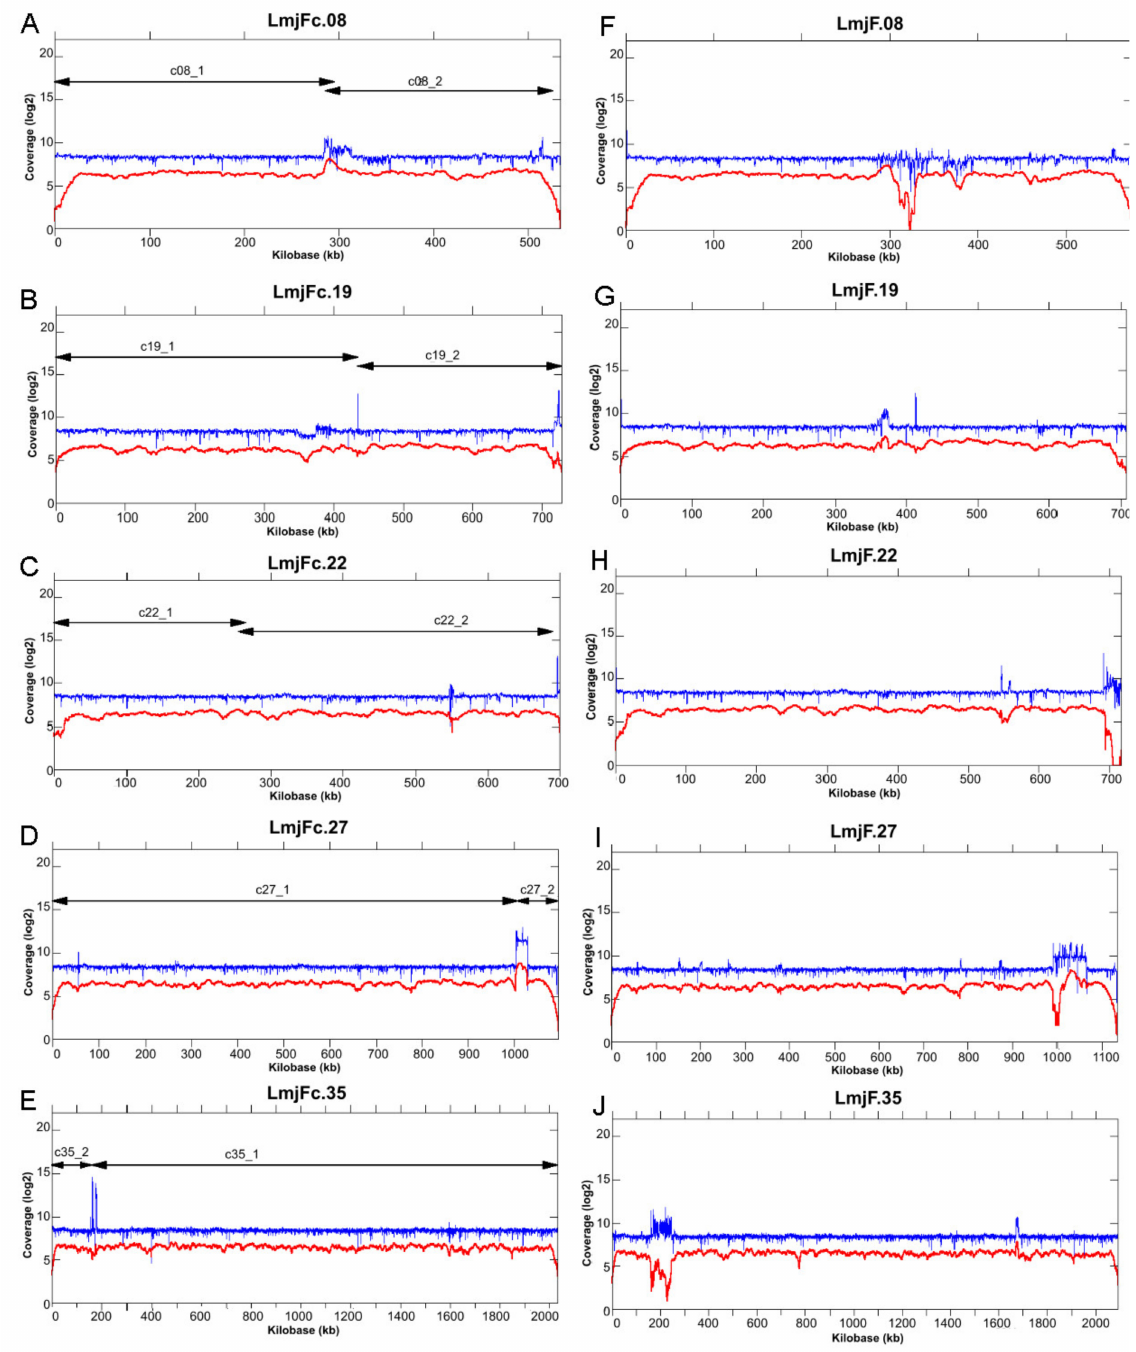
Figure 1. Read coverage along five chromosomes that resulted from joining two contigs. Illumina reads (in blue) and PacBio reads (in red) were mapped to the de novo assembled chromosomes (LmjFc) 8 (panel A ), 19 ( B ), 22 ( C ), 27 ( D ) and 35 ( E ), and to the corresponding chromosomes (panels F – J ) from the reference L. major genome (LmjF). The lines with arrow-heads denote the position of the two contigs joined to form the final